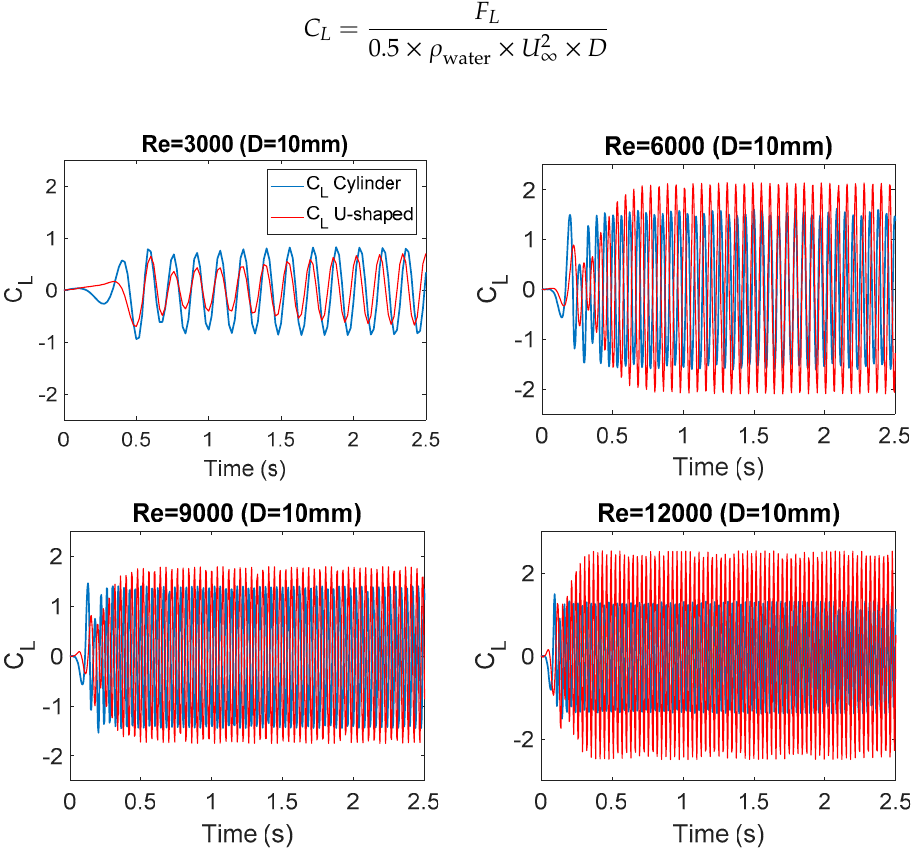
ffi cient at each Reynolds number ( D = 10 Figure 4. Evolution of the lift coefficient at each Reynolds number (D = 10 mm). Figure 4. Evolution of the lift coe